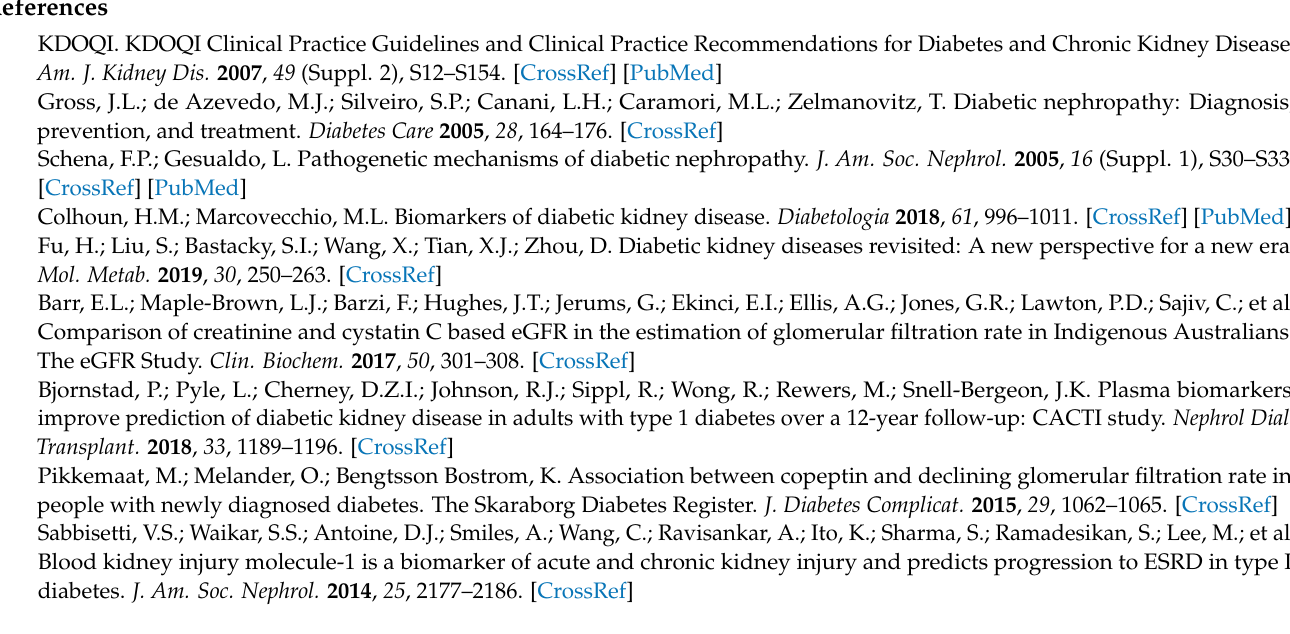
building, Table S2: SWATH-MS analysis for semi-quantification of compounds, Table S3: association between metabolites and clinical parameters, Table S4: differential abundance analysis, Table S5: iOmicsPASS